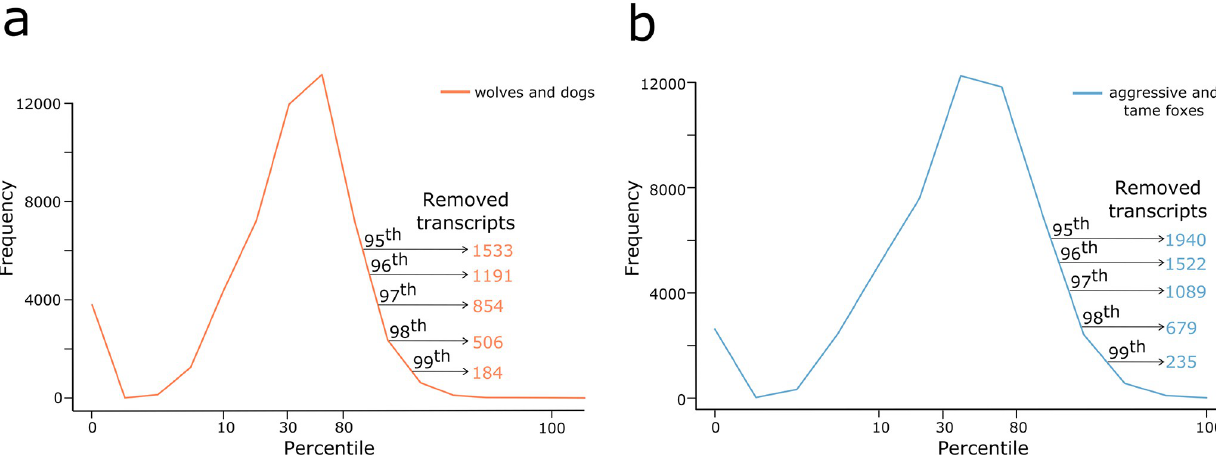
Fig 4. Removal of transcripts above specified levels of intra-condition variation. Percentile range of combined intra-condition variation scores (x-axis) present in each case study, a) wolves and dogs; b) tame and aggressive foxes. The number of transcripts removed in the top five percentiles (from the 95 th to the 99 th ) are presented in each